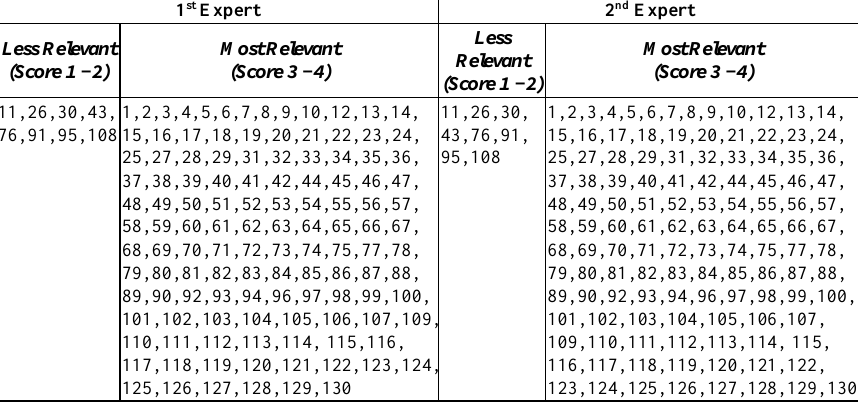
Table 5. The Content Validity Trial Results of the Tri Kaya Parisudha-Based Countenance Model Evaluation Instrument which were Conducted by Two Experts 1 st Expert 2 nd Expert Less Relevant (Score 1 - 2)